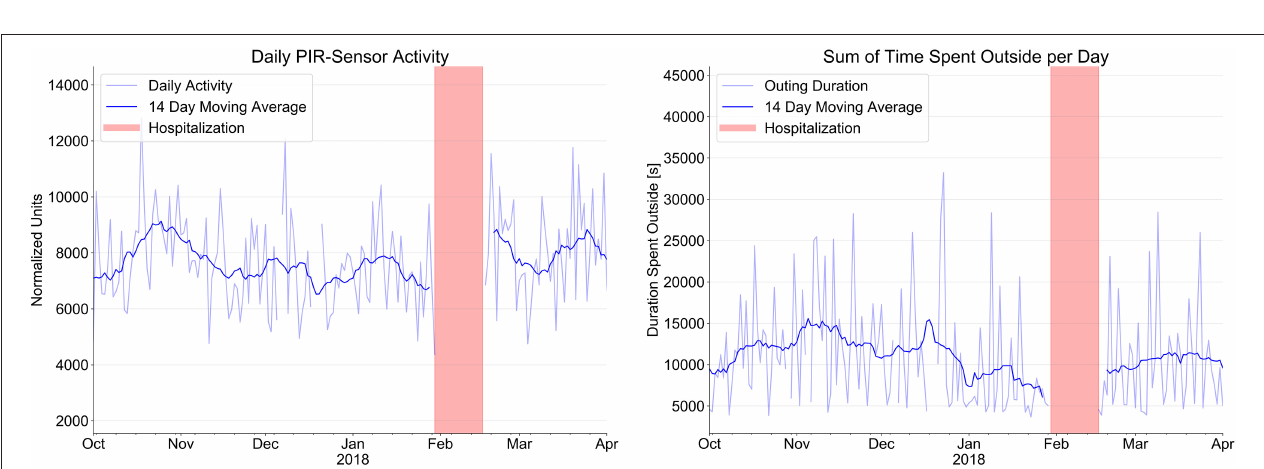
FIGURE 2 | Evolution of sensor signals from passive infrared PIR motion sensor system (normalized units) to indicate daily activity and time spent outside the apartment over a period of 4 month prior to hospitalization (red bars) and after hospital discharge.